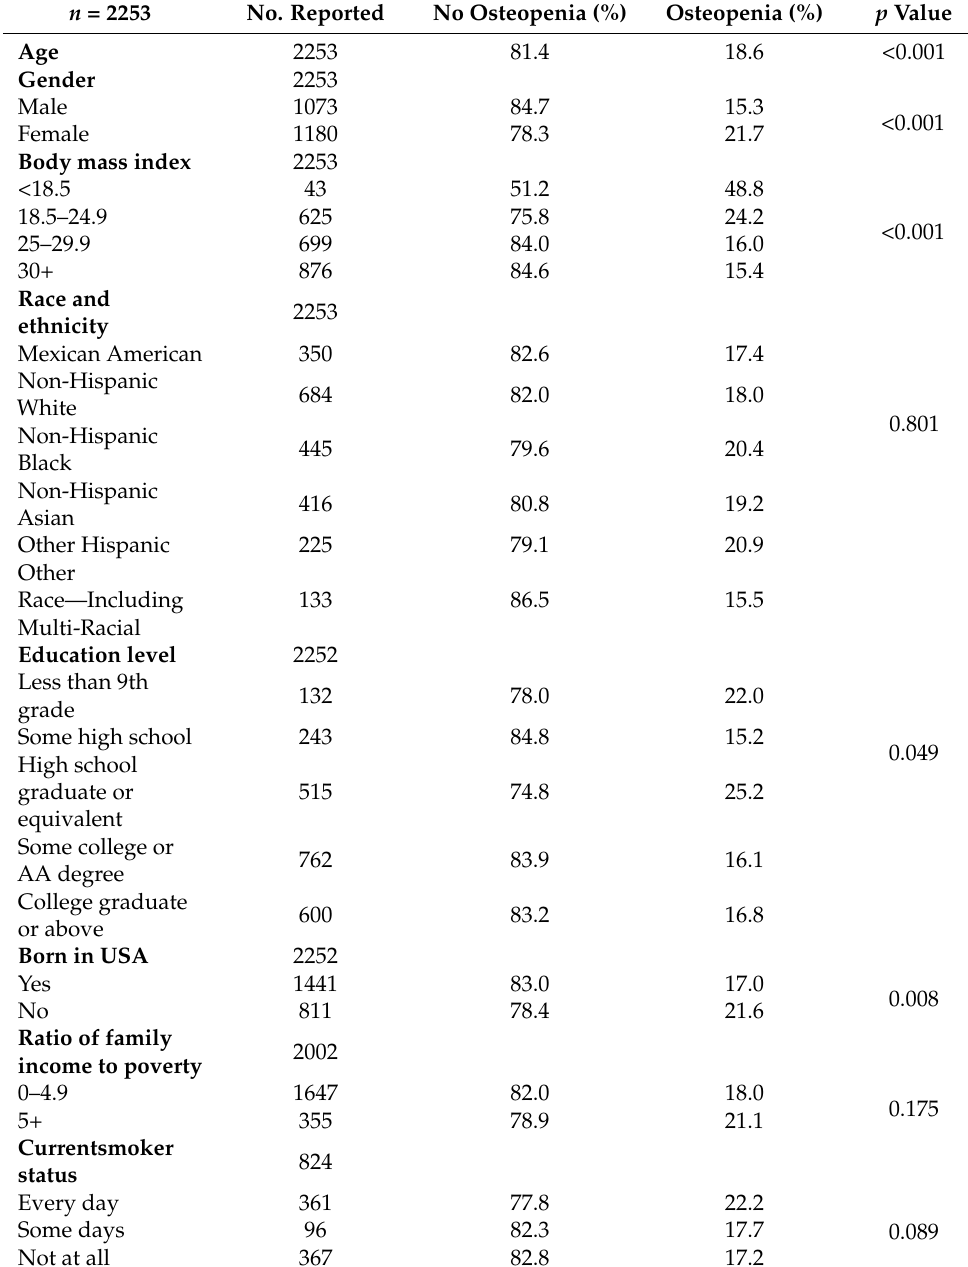
Table 1. Characteristics of American adults with osteopenia in